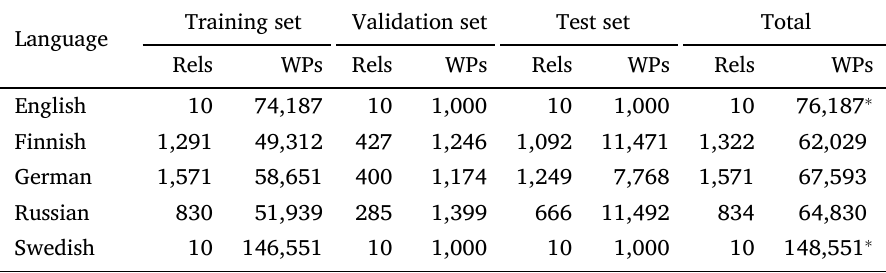
Table 2: Number of relations (“Rels”, after discarding size-1 relations) and word pairs (“WPs”) in the data set. *English and Swedish word pairs are all used exactly twice, once in original order, and once reversed. This means that the effective number of word pairs for these two languages are double the numbers in this